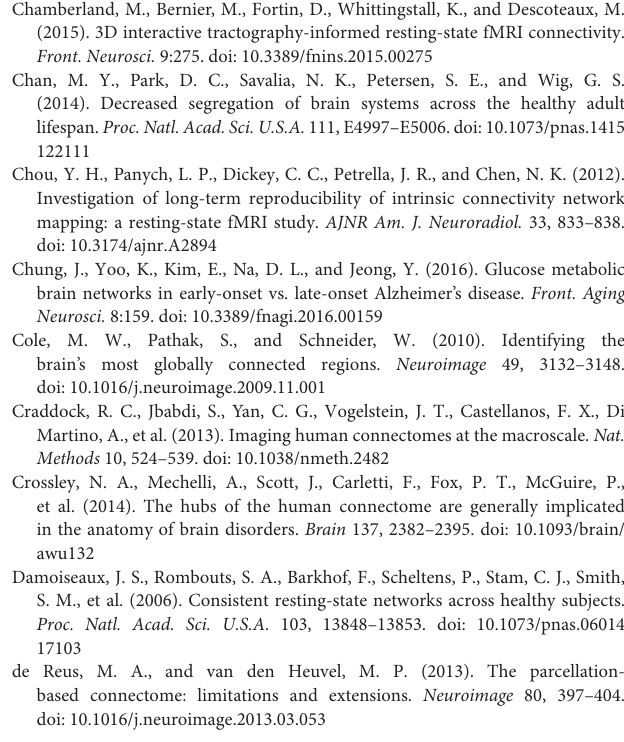
Supplementary Figure 1 | Different masks used for reproducibility analysis. Figure shows two sets of mask that were used to test reproducibility for inter-regional correlational analysis. The red mask is the original mask used in analysis of AD subjects and the green masks is a new set of masks which are derived from ICA analysis on a separate